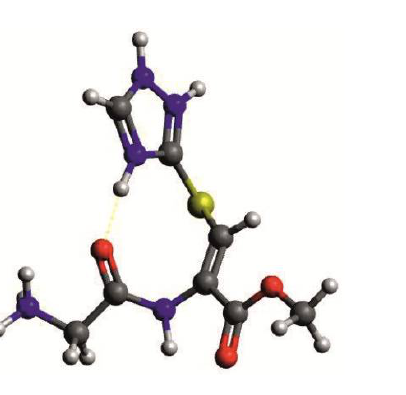
Figure 1. The proposed structure of the fully protonated 9a